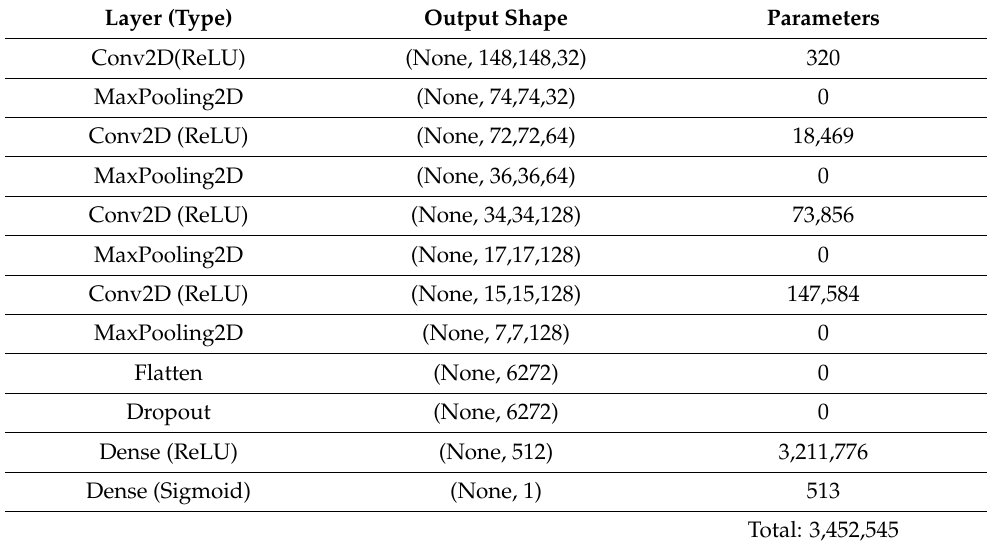
Figure 3. The structure of the architecture. Table 2. Summary of the CNN model used with layers, output shapes, and the number of